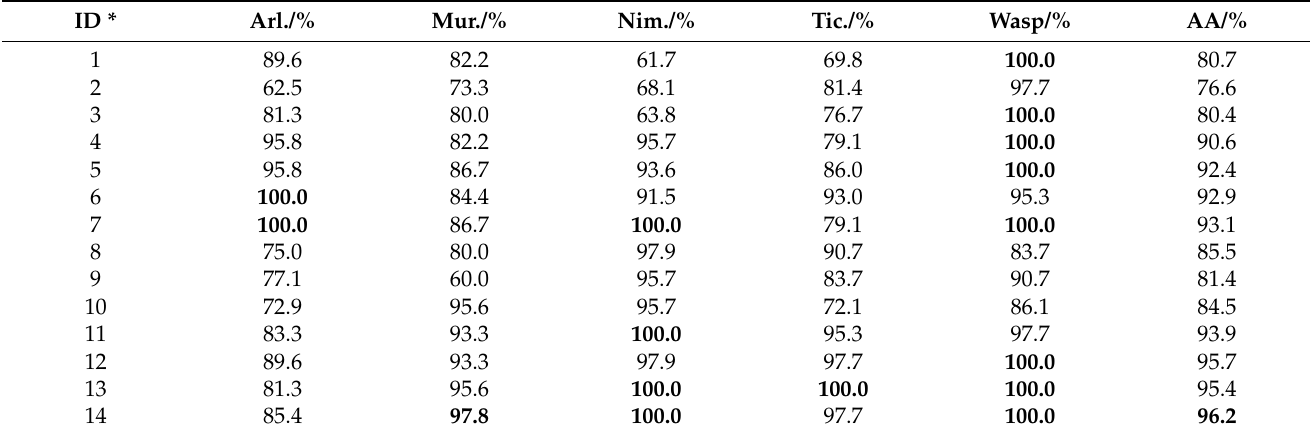
Table 4. Accuracy of each class and average